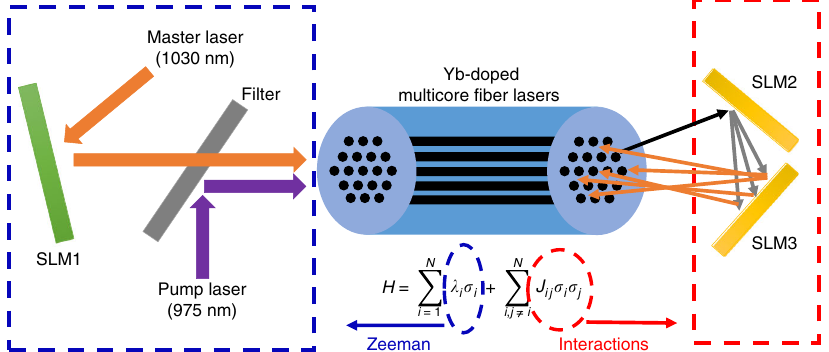
Fig. 3 The proposed architecture for the coherent Ising machine (CIM). The injection-locked laser system consists of an Ytterbium doped multicore fi ber (MCF) as the slave lasers (SLs), locked to a single frequency master laser (ML). The spatial light modulator 1 (SLM1) is used to implement Zeeman terms via a small change in the vertical polarization state of ML. SLM2 and SLM3 are the elements to program the interaction terms ( J ij